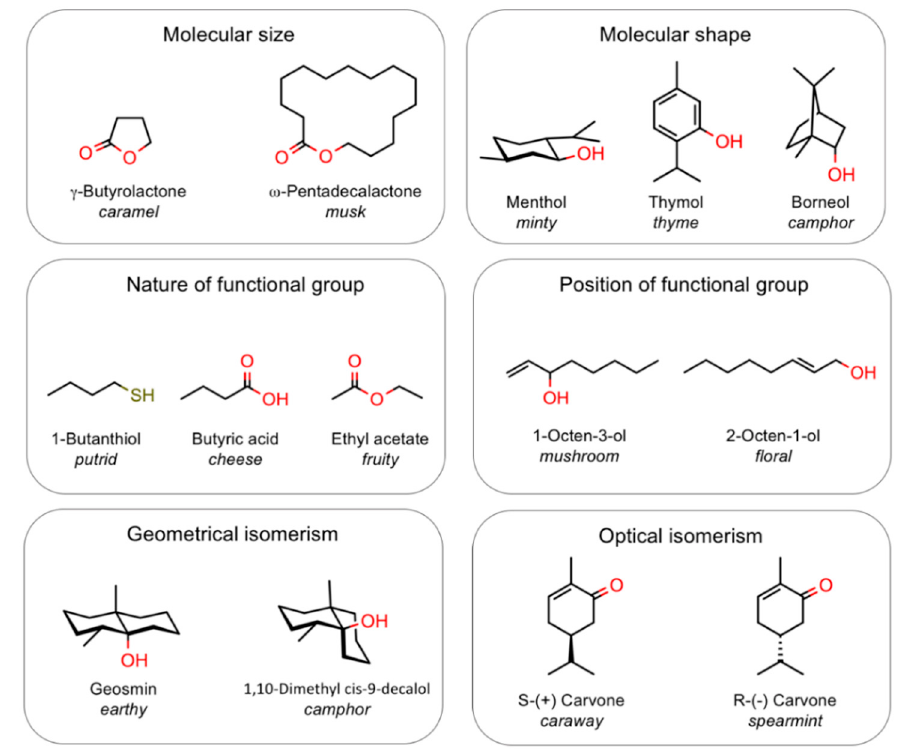
Figure 1. Complexity of odour coding. Smell can be only analysed in a multidimensional space, where different molecular parameters contribute to the perceived odour. The examples reported in the figure illustrate the effect of functional groups (nature and position), as well as stereochemical parameters on odour quality. Cases have been reported of enantiomer pairs smelling different, although this is not common in human olfaction.